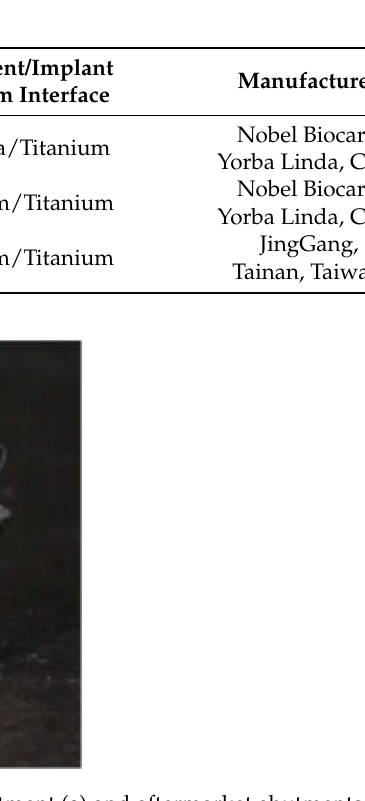
Figure 1. Titanium insert of NobelProcera ASC abutment ( a ) and aftermarket abutments ( b ).